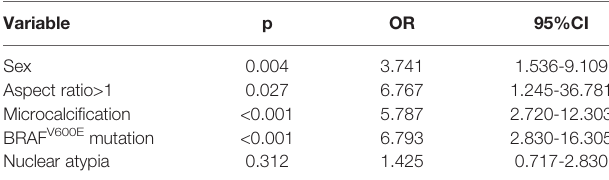
TABLE 2 | Multivariate analysis of the association between clinical and sonographic variables and postoperative pathology. Variable